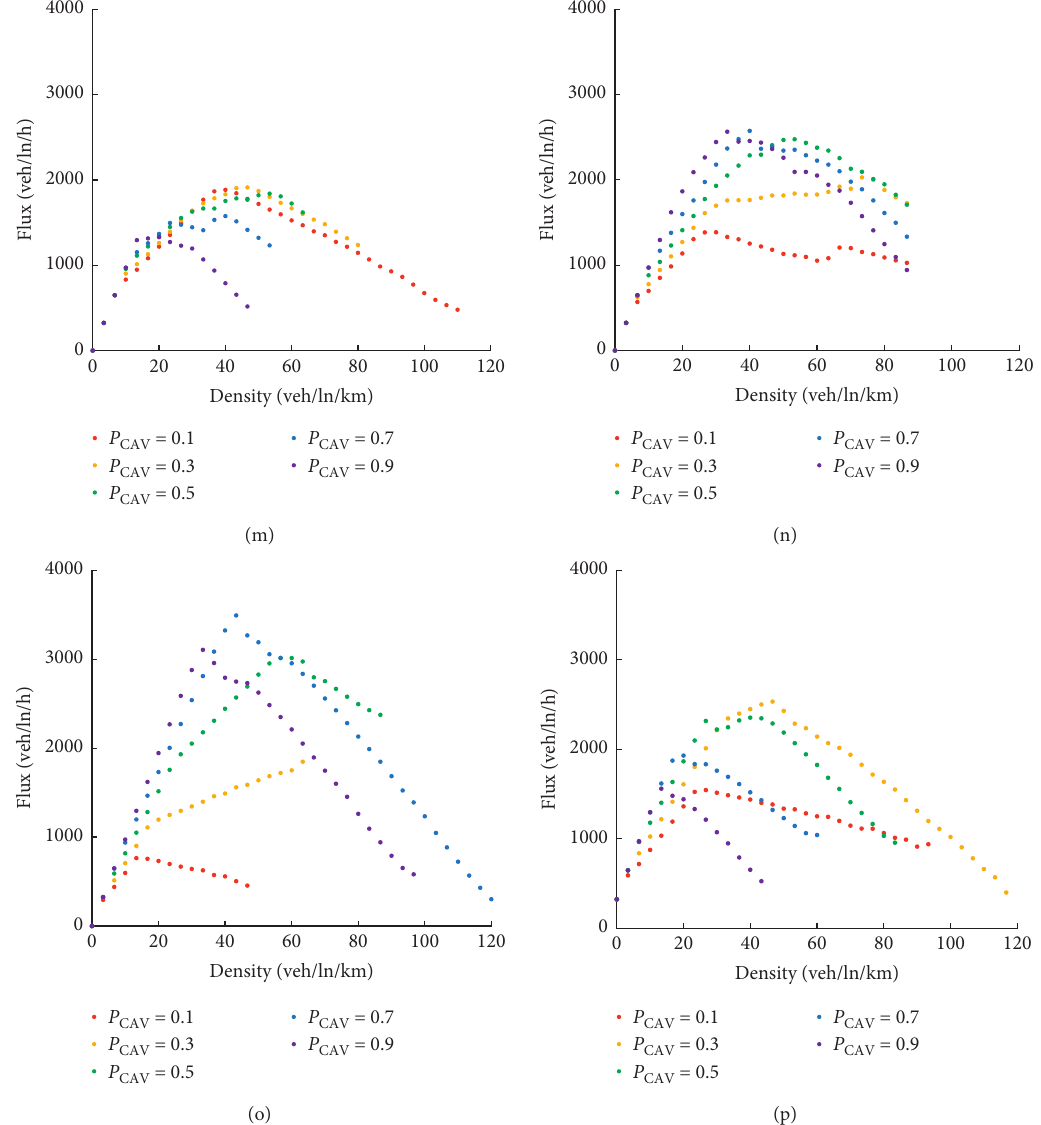
Figure 2: Flow-Density relationship diagram with different lane policies. (a) GG. (b) GC. (c) GM. (d) CM. (e) GGG. (f) CGG. (g) GCG. (h) MGG. (i) GMG. (j) CCG. (k) CGC. (l) MMG. (m) MGM. (n) CGM. (o) CCM. (p)